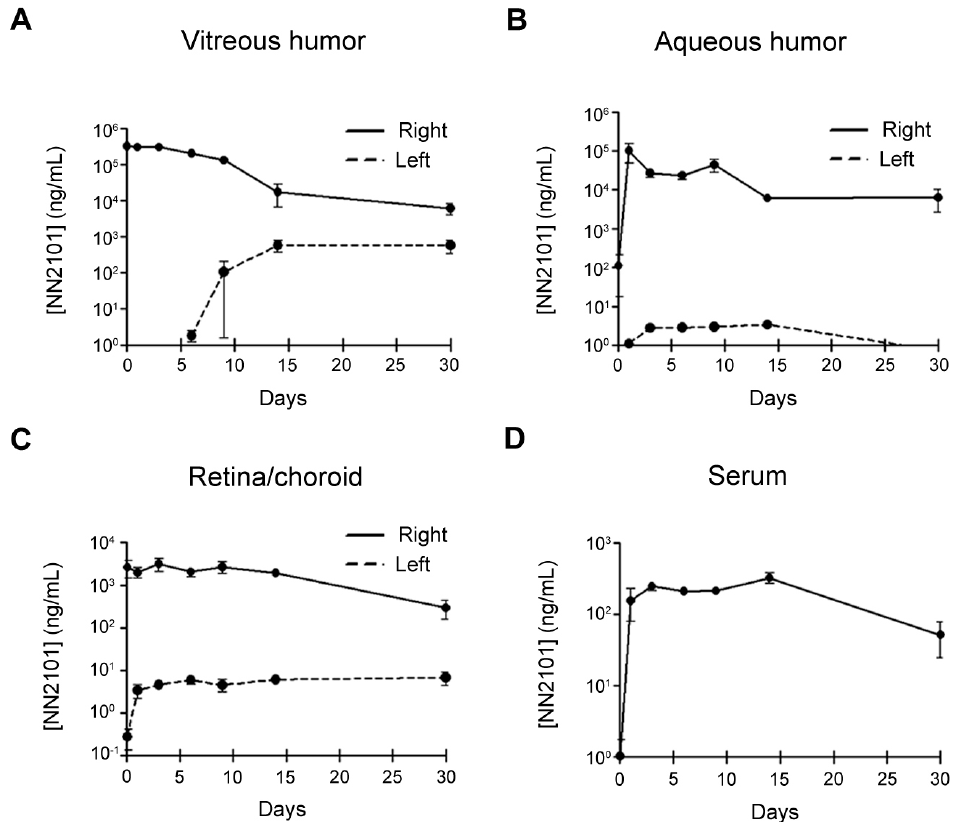
Figure 6. Time-concentration plots for NN2101 in the eyes and serum of rabbits after intravitreal injection. Concentration of NN2101 in vitreous humor ( A ), aqueous humor ( B ), retina and choroid tissues ( C ), and serum ( D ) of rabbits after intravitreal injection of NN2101 (600 μ g in 30 μ L) is shown. Samples were taken from the injected right (solid line) and uninjected left (dashed line) eyes over 30 days, and the concentration of NN2101 was assessed using indirect ELISA. The data are expressed as the mean ± SEM ( n = 3 rabbits per time point). Table 1. PK parameters of NN2101 in the vitreous humor, aqueous humor, retina/choroid, and serum of rabbits.